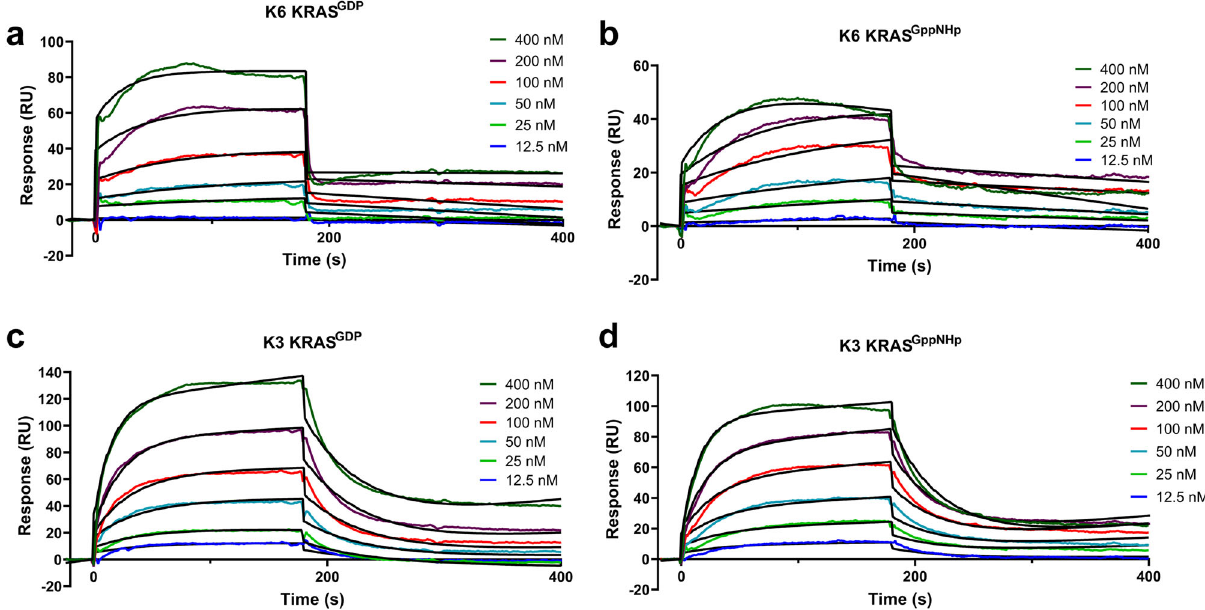
Fig. 5 Af fi mers K3 and K6 bind KRAS with nanomolar af fi nity. SPR measured binding activities for Af fi mer K6 with GDP bound KRAS ( a ), GppNHp bound KRAS ( b ) and Af fi mer K3 with GDP bound KRAS ( c ), GppNHp bound KRAS ( d ). Af fi mers were immobilized on streptavidin-coated CM5 sensor chips via C-terminal biotin and differing concentrations of GDP or GppNHp bound KRAS fl owed over. Representative curves of 3 replicate experiments are shown with experimental data in color and Langmuir 1:1 fi tting curves in